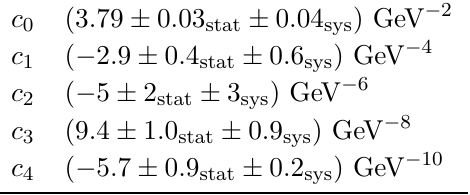
Table 3 . Final estimates for the Taylor-series coefficients of the gluon propagator. In each line, the first uncertainty is statistical while the second is systematic, obtained from the spread of values from the different